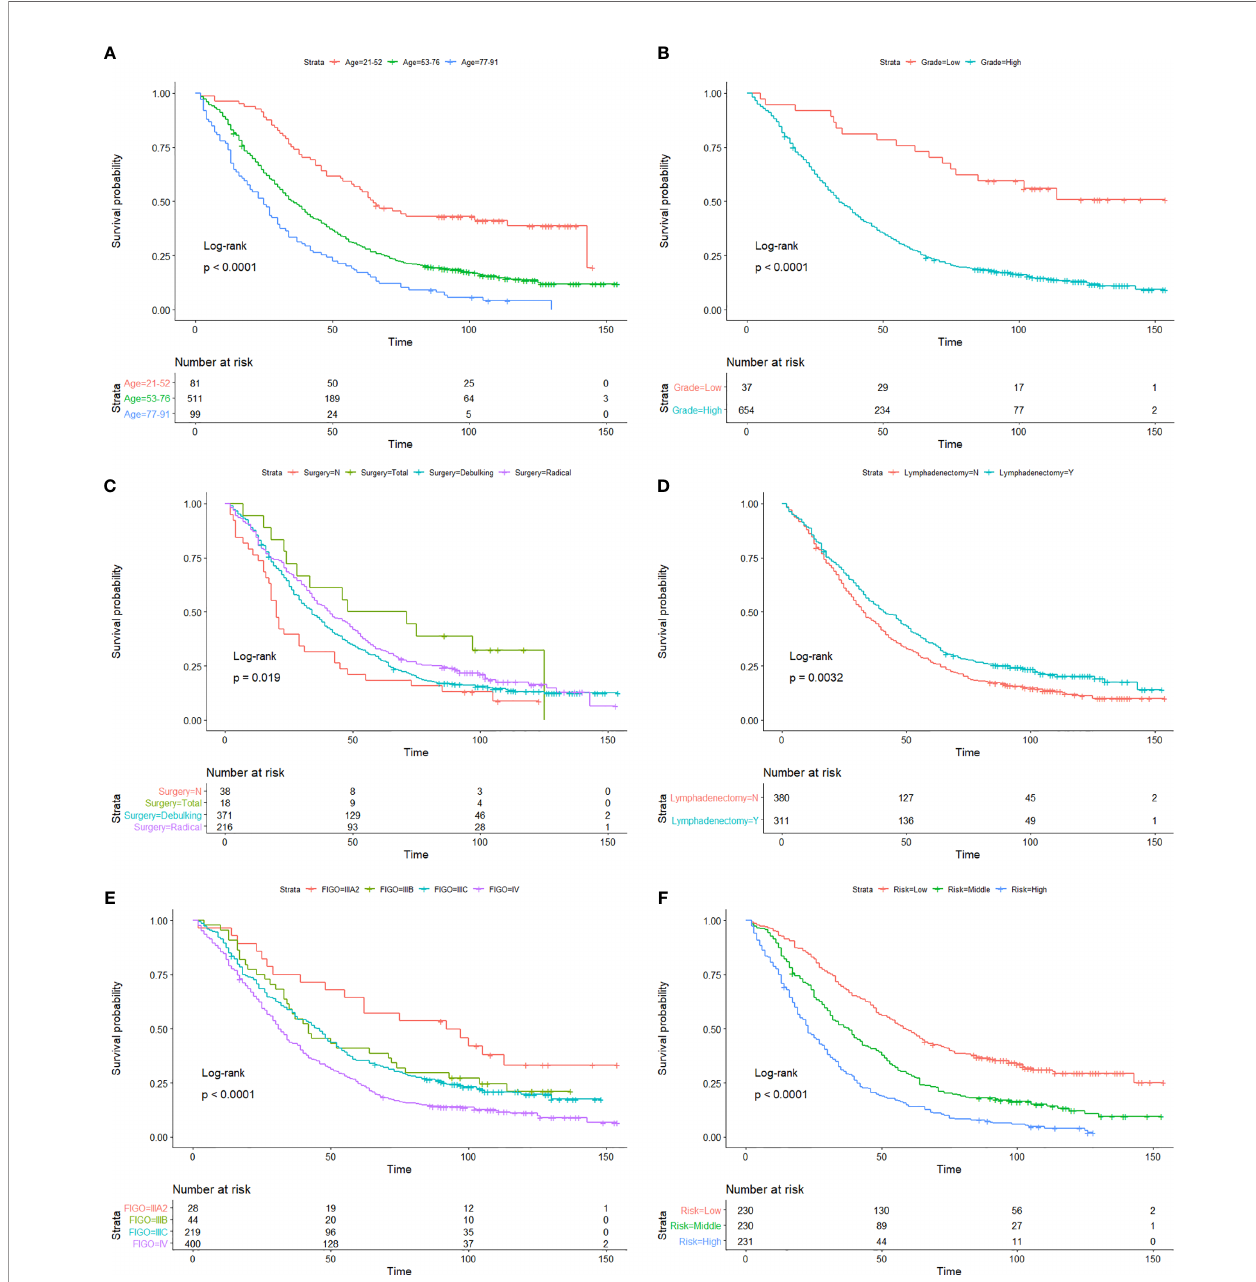
FIGURE 3 | Kaplan-Meier OS curves of age (A) , histological grade (B) , surgery type (C) , lymphadenectomy (D) , FIGO staging system (E) , and risk strati fi cation (F) in the developmental